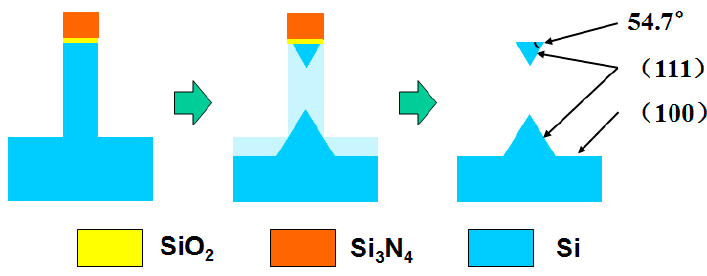
Figure 5. The diagram of triangular suspended nanowire by TMAH.